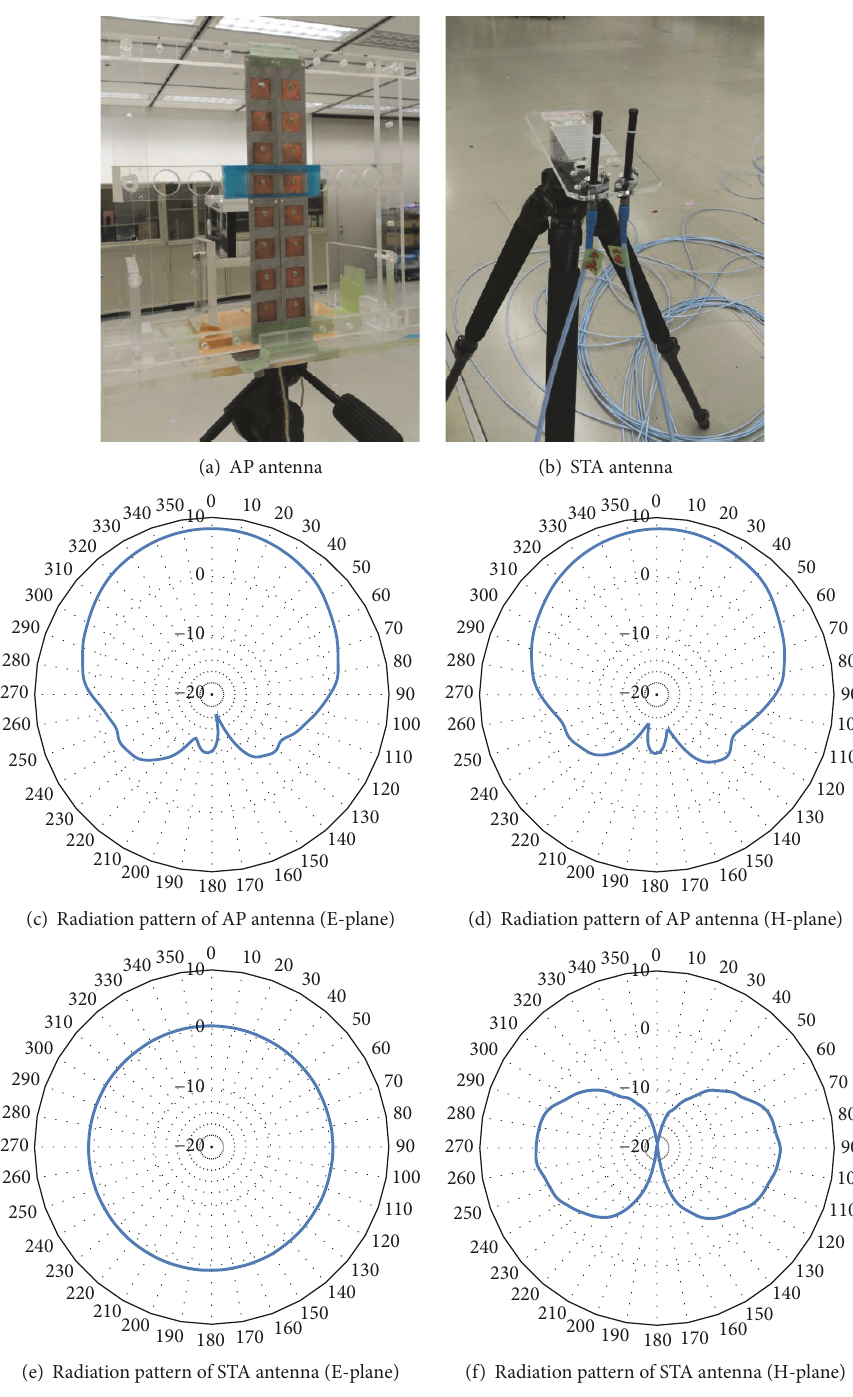
Figure 7: Photographs and radiation patterns of AP and STA antennas.